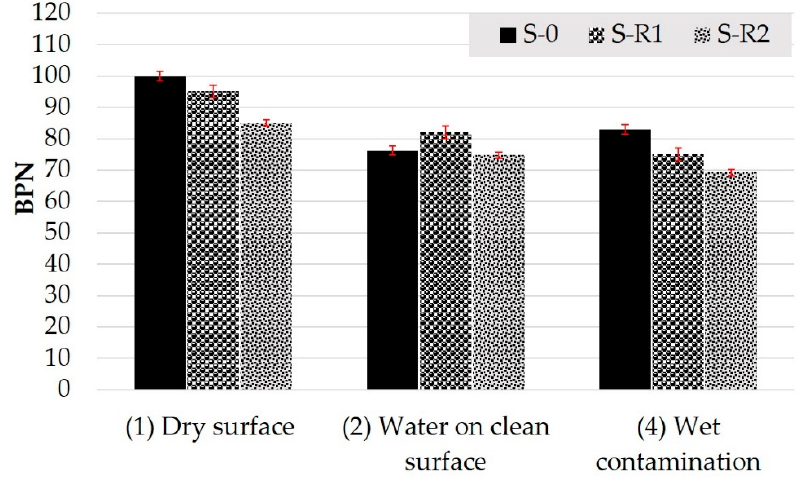
wet asperities of the mixture used for simulating contamination and the asperities of the asphalt mixture aggregates [63]. Figure 17. BPN levels during phases (1), (2), and (4) for the S-0, S-R1, and S-R2 specimens.